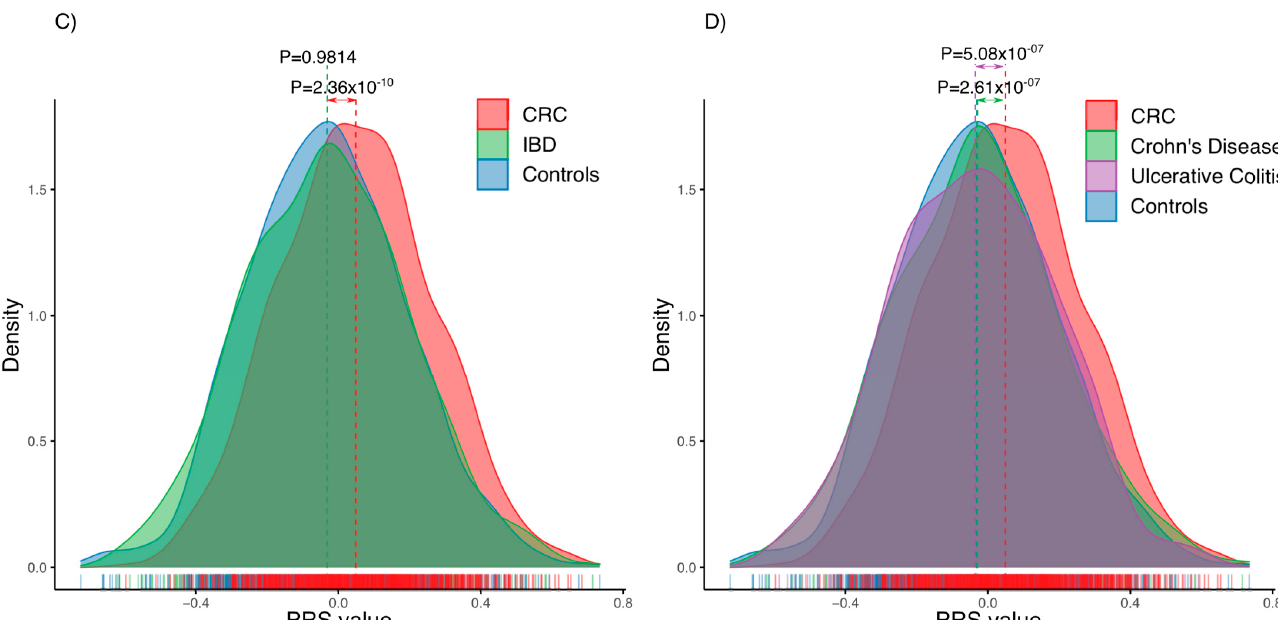
Figure 3. Distribution of polygenic risk score based on PGS000785 set. P, the p -value of the T-test. ( A ) Colorectal cancer. ( B ) According to the location. ( C ) Comparison with patients with irritable bowel disease. ( D ) Comparison with patients of main types of irritable bowel disease.